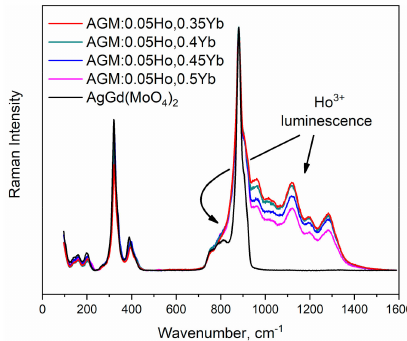
Figure 8. Raman spectra of AGM and AGM: x Ho, y Yb ( x = 0.05; y = 0.35, 0.4, 0.45, 0.5) samples.